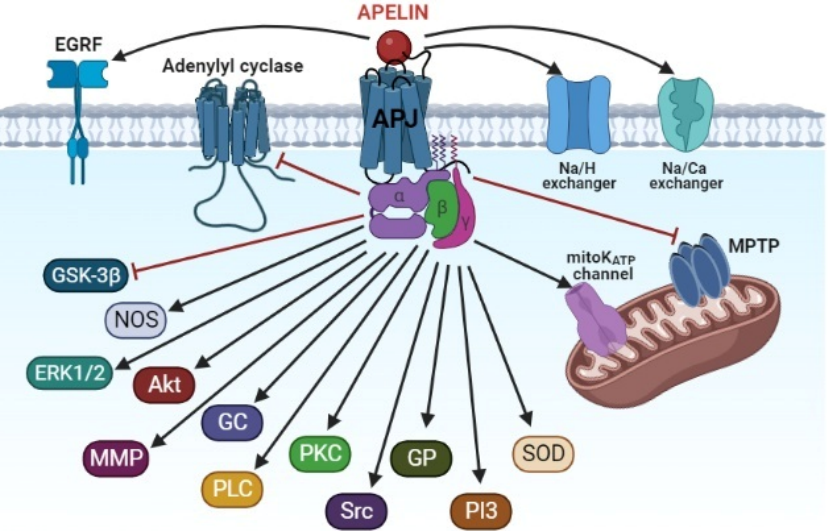
Figure 3. The signaling mechanism of the cardioprotective effect of apelins. Akt, protein kinase B; APJ, apelin receptor; EGRF, epidermal growth factor receptor; ERK1/2, extracellular regulated kinase; GC, guanylyl cyclase; GP, glutathione peroxidase; GSK-3 β , glycogen synthase kinase-3 β ; MMP, matrix metalloproteinase; MPTP, mitochondrial permeability transition pore; NOS, NO-synthase; PI3, phosphoinositide-3-kinase; PKC, protein kinase C; PLC, phospholipase C; SOD, superoxide dismutase; Src, protooncogene, non-receptor tyrosine kinase.